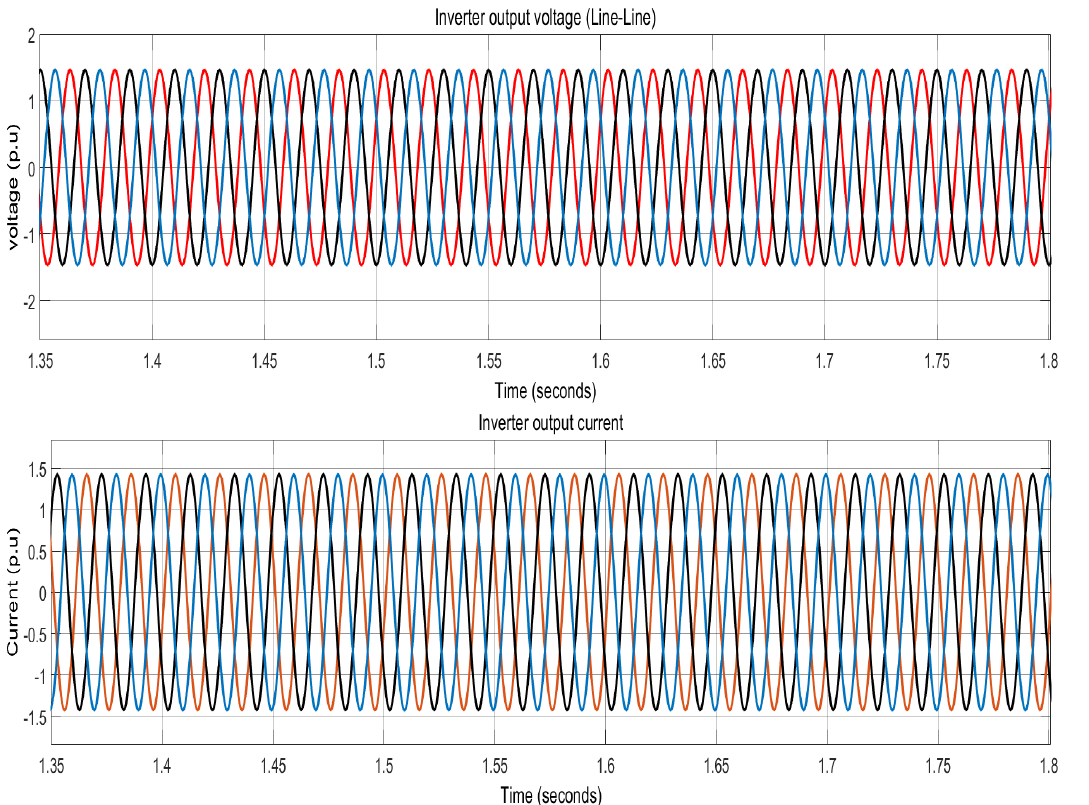
Figure 25. Inverter output voltage and